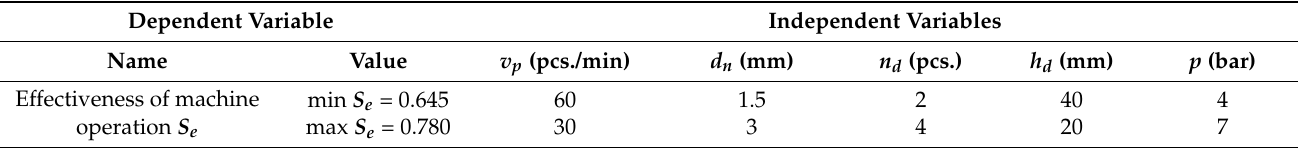
Table 4. Layouts of independent variables for the smallest and largest values of the dependent variable S e . Dependent